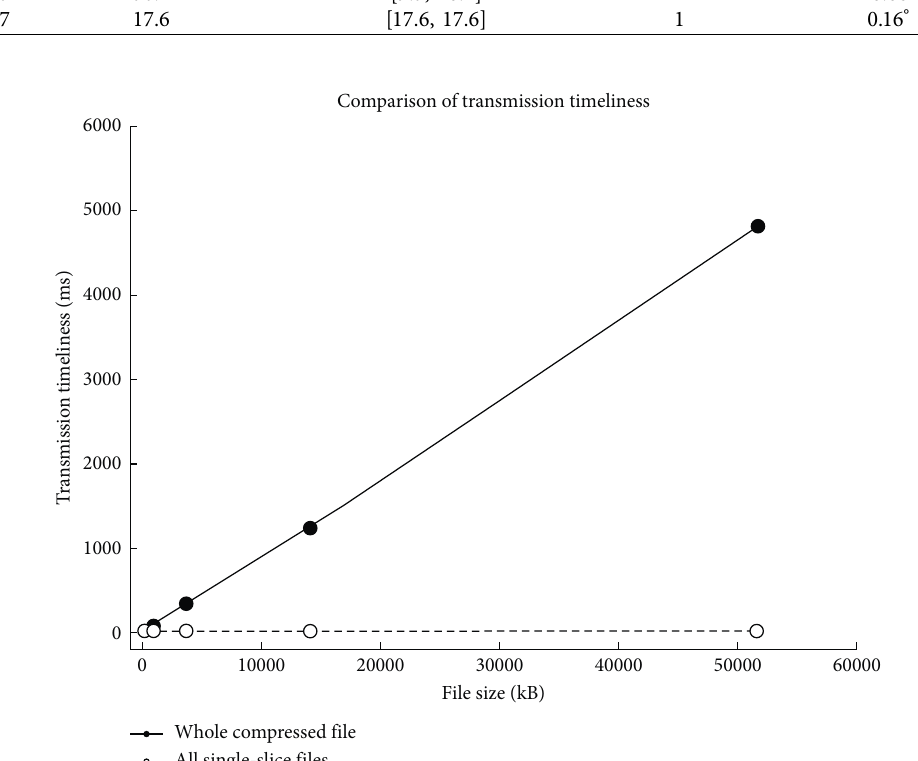
Figure 5: Comparison of transmission timeliness between the whole compression file and the slices.